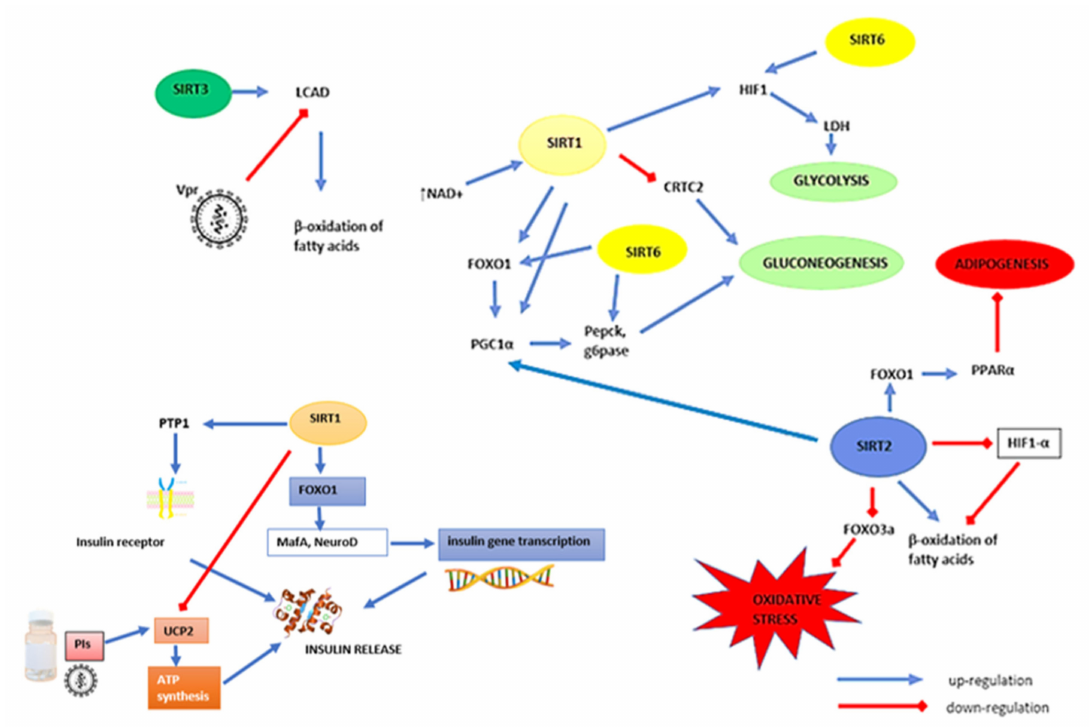
Figure 4. Scheme of connection between sirtuins, carbohydrate metabolism and HIV infection. SIRT1, by deacetylation of FOXO1, activates the transcription factors MafA and NeuroD and increases the expression of the insulin gene in pancreatic β cells. By deacetylation of PT-1B, SIRT1 reduces its insulin signal transduction and insulin release inhibitory activity. SIRT1 binds to the promoter for UCP2, inhibits the process of reducing ATP synthesis and restores insulin release from pancreatic β cells. Protease inhibitors act the opposite of SIRT1, they increase the activity of UCP2. SIRT1 down-regulates CRTC2, inhibiting gluconeogenesis during an extended fasting period. Deacetylation of FOXO1 and its co-activator PGC-1 α by SIRT1, increases the transcription of gluconeogenesis genes. SIRT1 and SIRT6 deacetylates the HIF-1 by reducing its transcriptional activity, thereby intensifying glycolysis. SIRT2 regulates redox homeostasis by deacetylation of FOXO3a, which increases MnSOD expression and the reduced form of glutathione. In adipocytes, SIRT2 deacetylates PGC-1 α , intensifying fatty acid catabolism and gluconeogenesis. SIRT2 also inhibits adipogenesis through deacetylation of FOXO1, promoting its binding to PPAR α and reducing its transcriptional activity. SIRT3 deacetylates a key enzyme responsible for liver β -oxidation of fatty acids, LCAD, increasing its activity. Vpr viral protein reduce β -oxidation of fatty acids in the liver and decreases expression of LCAD. The effect of SIRT6 on glucose metabolism is associated with the inhibition of gluconeogenesis via the PGC-1 α , which in turn inhibits the expression of PEPCK and glucose 6-phosphatase, associated with gluconeogenesis. SIRT6 also acts by deacylating FOXO1-inhibiting gluconeogenesis. SIRT1,2,3,6, sirtuin 1,2,3,6; HIF1, hypoxia inducible factor-1; LDH, lactate dehydrogenase; CRTC2, CREB regulated transcription coactivator 2;